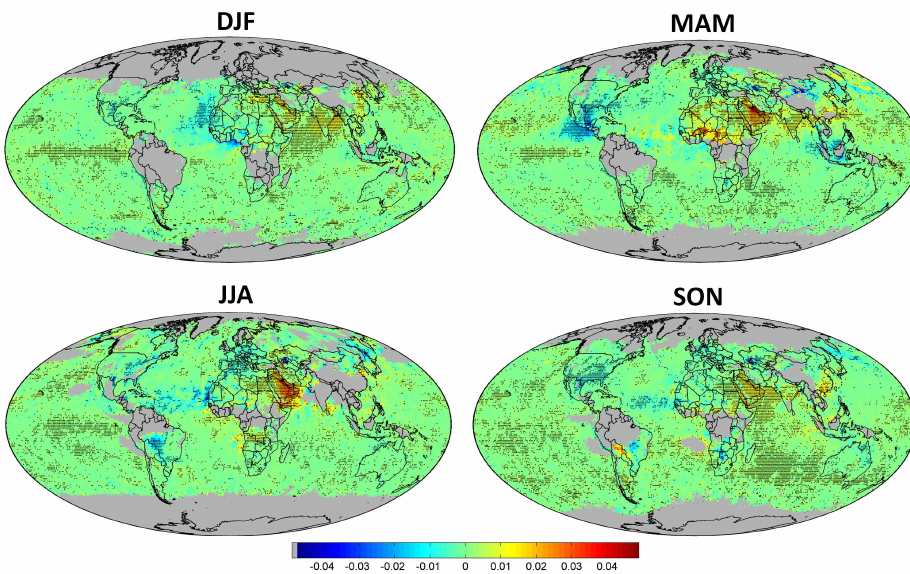
Fig. 11. Seasonal trends of SeaWiFS AOD anomaly from January 1998 to December 2010. Dots indicate significance at 95% confidence level. Units are AODyr − 1 . The grey color represents the regions with no data or insufficient sample size for trend analysis due to the presence of frequent cloud cover or snow/ice.